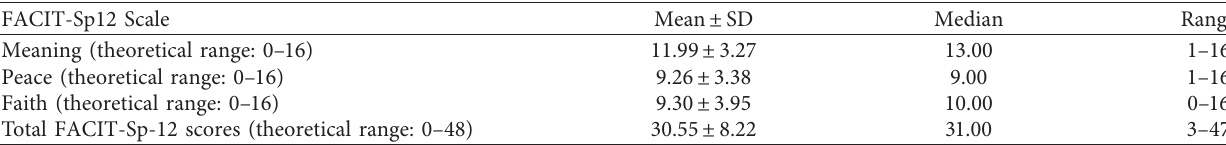
Table 2: Descriptive statistical measures of FACIT-Sp12 Scale ( n � 367).